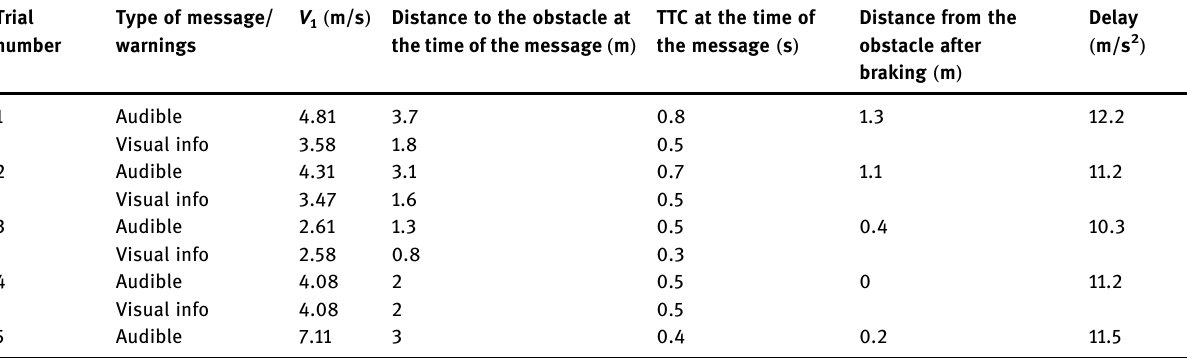
Table 8: Summary of the results for trials with a high value for the braking rate Trial Type of message/ number